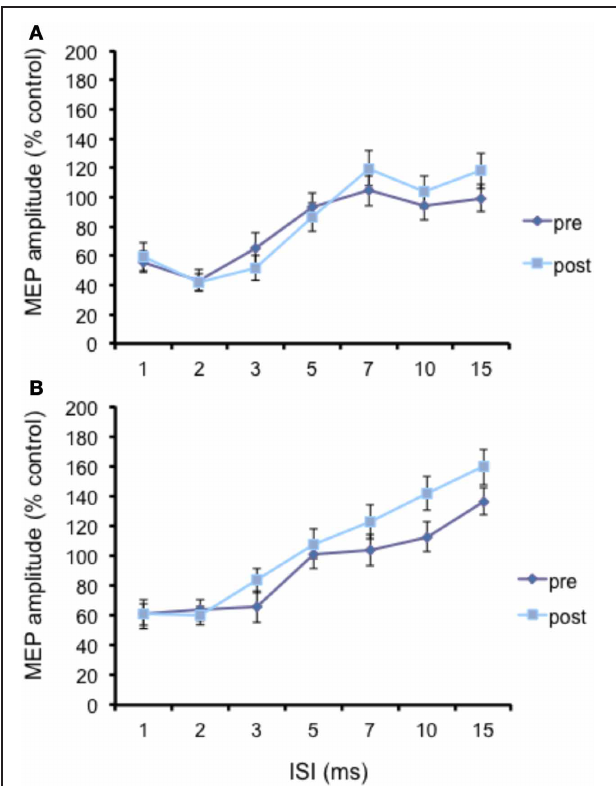
FIGURE 4 | Effects of cerebellar cTBS on SLAI (A) and SICI and ICF (B) in healthy subjects. Error bars indicate standard deviations. The size of MEPs is expressed as a percentage of the MEP evoked by magnetic stimulation alone. Error bars indicate mean standard errors. ∗ p < 0 . 05.